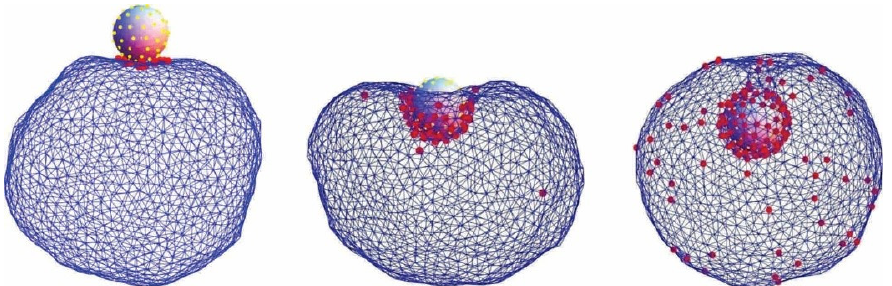
Figure 1. Encapsulation of a spherical charged particle macro-ion. Snapshots of representative configurations obtained from Monte Carlo simulations for different numbers of charged lipids (each having one unit charge) in the membrane: 15, 60, and 150 (from left to right). The right figure corresponds to the situation of nearly complete encapsulation of the macro-ion. The spherical particle carries 65 uniformly distributed, point-like cations of valence 2. Reprinted from [30] with permission of AIP